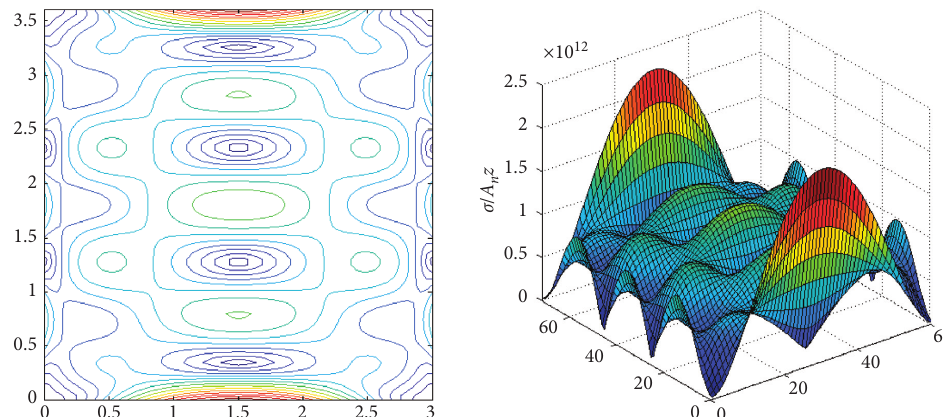
Figure 8: The maximum shear of the 5 th order mode